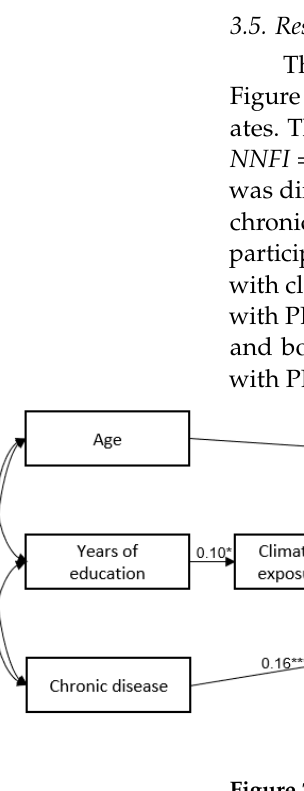
Figure 2. Path analysis for climate change exposure, climate change risk appraisal, environmental self-efficacy, collective efficacy, and pro-environmental behaviors (PEBs). * p < 0.05, ** p < 0.01, *** p < 0.001. Note: Solid lines: significant associations. Dashed lines: nonsignificant associations. Unidirectional arrows: path β values, bidirectional arrows- correlations. Values on arrows— β values; values within the rectangles— R 2 .